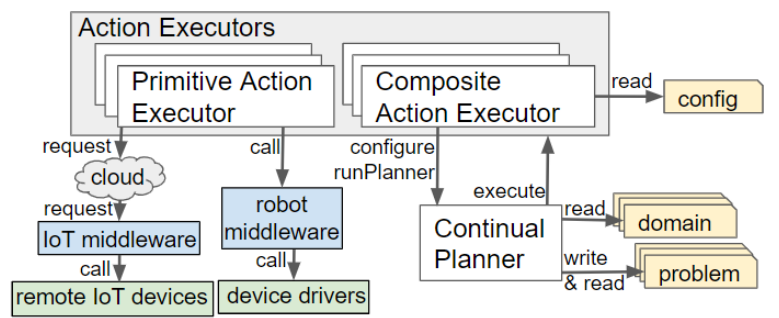
Figure 5. Functionality of the types of Action Executors. Grey boxes indicate types of plug-ins, white indicates classes/instances and yellow shows